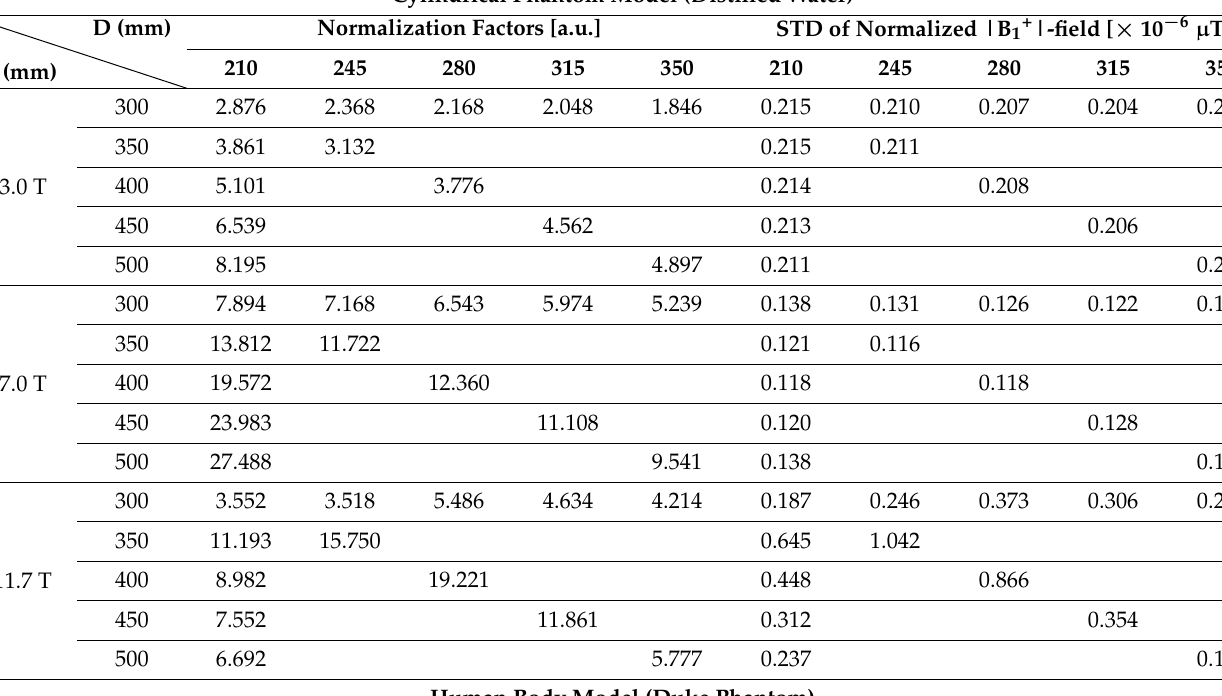
Human Body Model (Duke Phantom) Normalization Factors